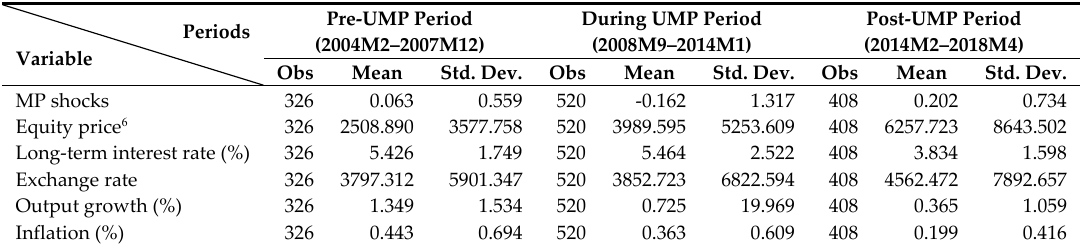
Table 1. Descriptive Statistics of Panel Data for Three Periods. UMP: unconventional monetary policy.